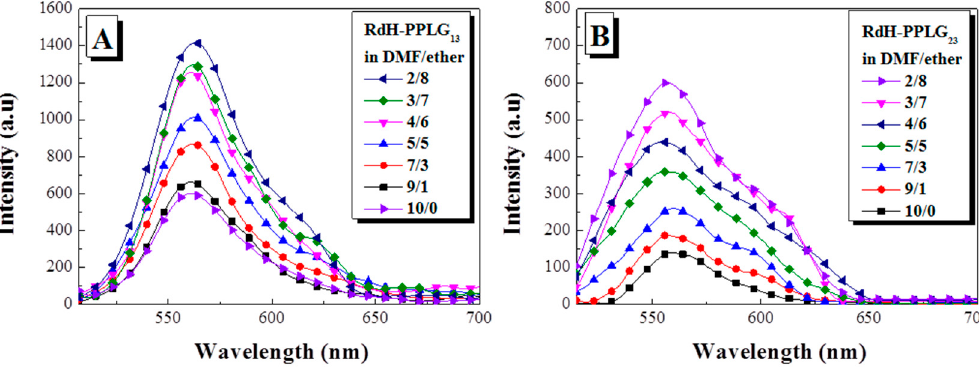
Figure 5. Emission spectra of: ( A ) R–PLG 23 (10 − 4 M); and ( B ) R–PLG 13 (10 − 4 M) in solution mixtures of DMF/ether of different compositions ( λ ex = 490 nm).